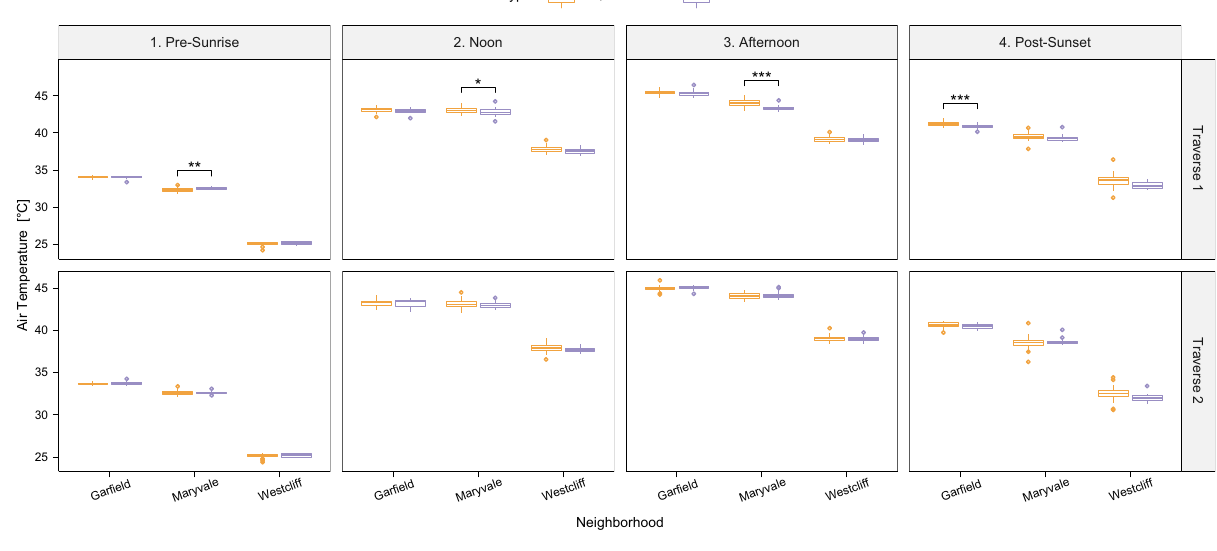
Fig. 4 | Overview ofair temperature measurements for all areas and times. Car transect-derived air temperature panel for all neighborhoods, transects, and tra- verses in box-whisker plots. Center line=median; box limits=upper and lower quartiles;whiskers=1.5xinterquartilerange;points=outliers.Asphaltconcrete,AC